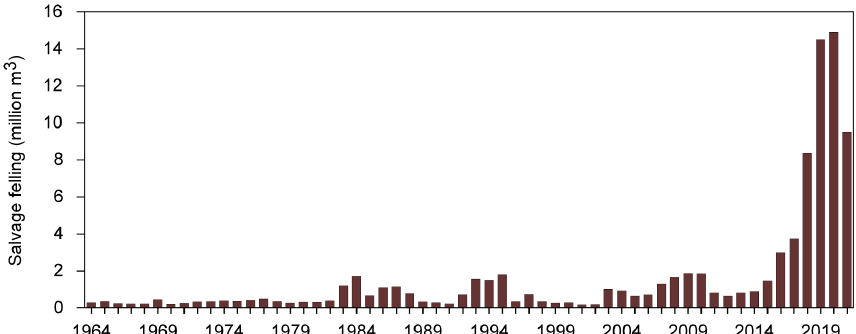
Figure 2. Fluctuations in bark beetle salvage felling ( × 10 6 m 3 of wood) for the Czech Republic in the 1964–2021 period (source of data: Research Institute of Forestry Economics and